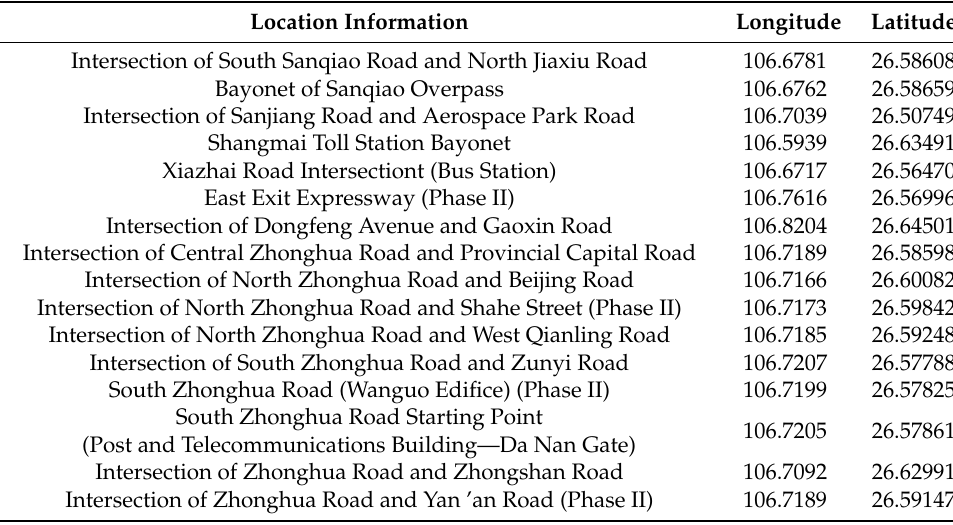
Table 2. Partial results of longitude and latitude